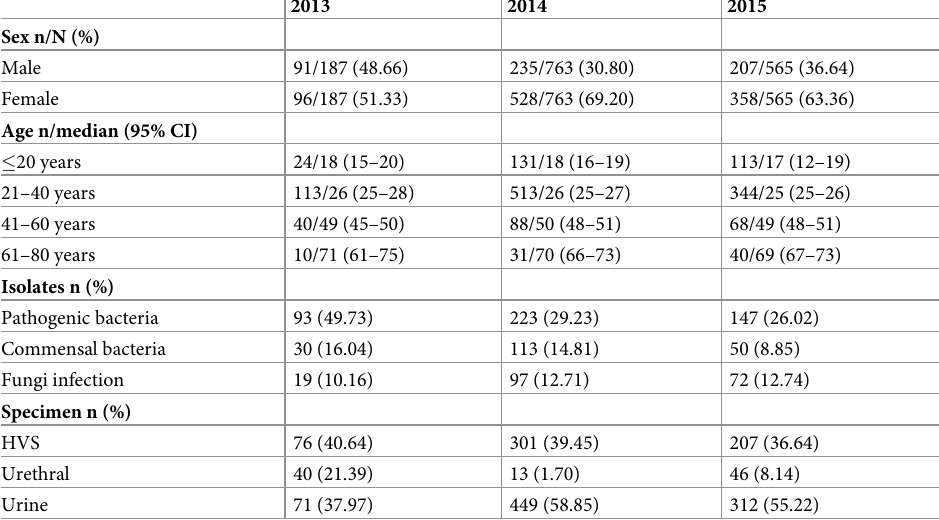
Table 1. Demographic characteristics of the